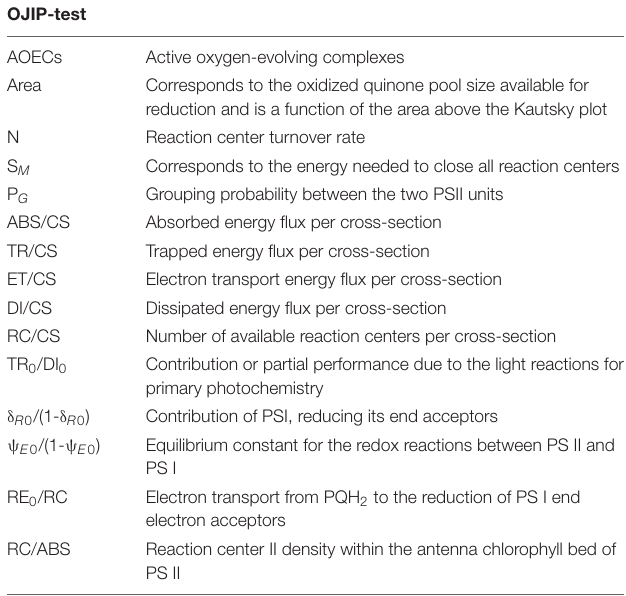
TABLE 1 | Summary of fluorometric analysis parameters and their